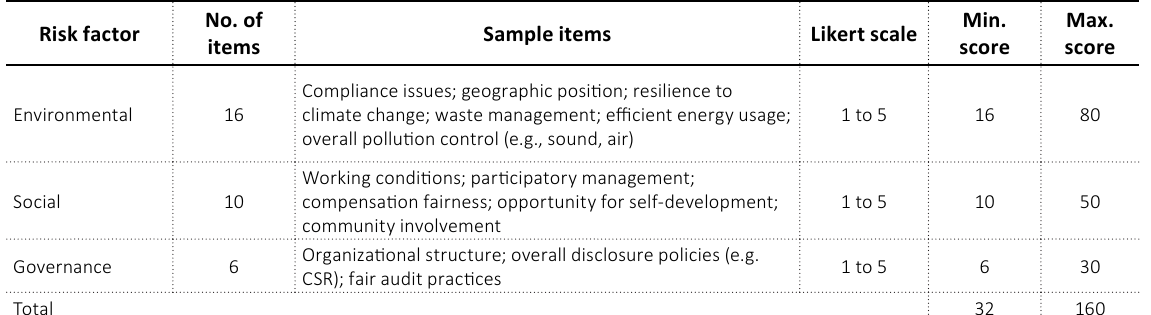
Table 2. ESG score